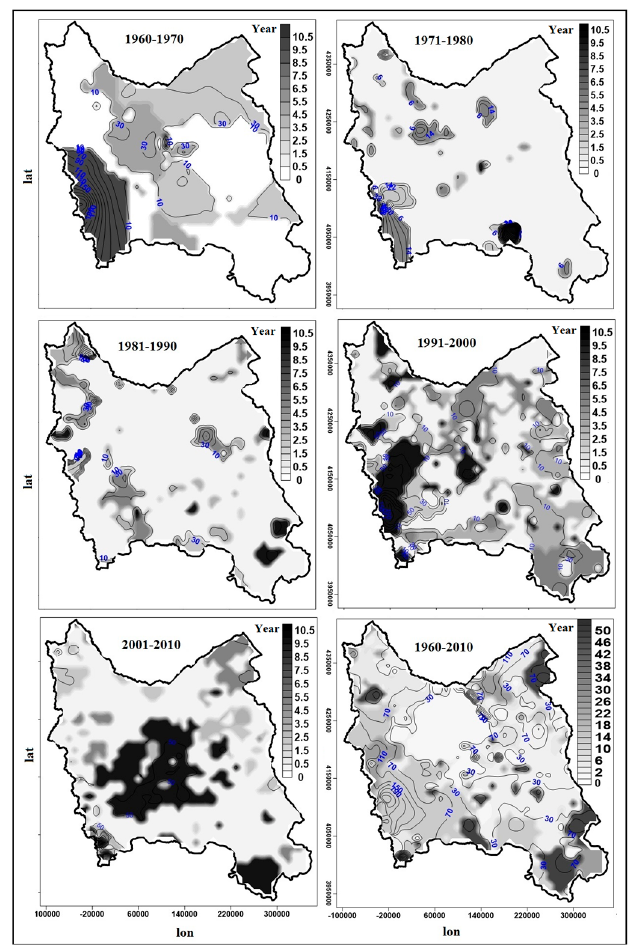
Figure 4. Spatial distribution of return period and variance of extreme precipitation thresholds in the northwest of Iran.